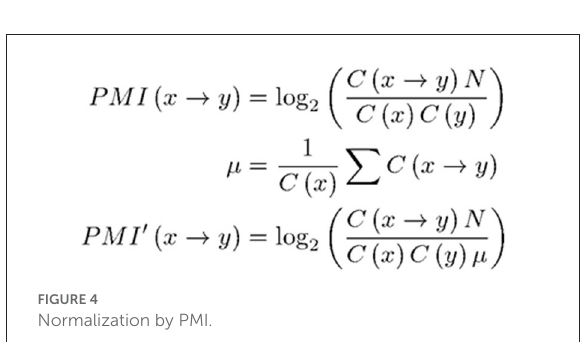
FIGURE4 Normalization by